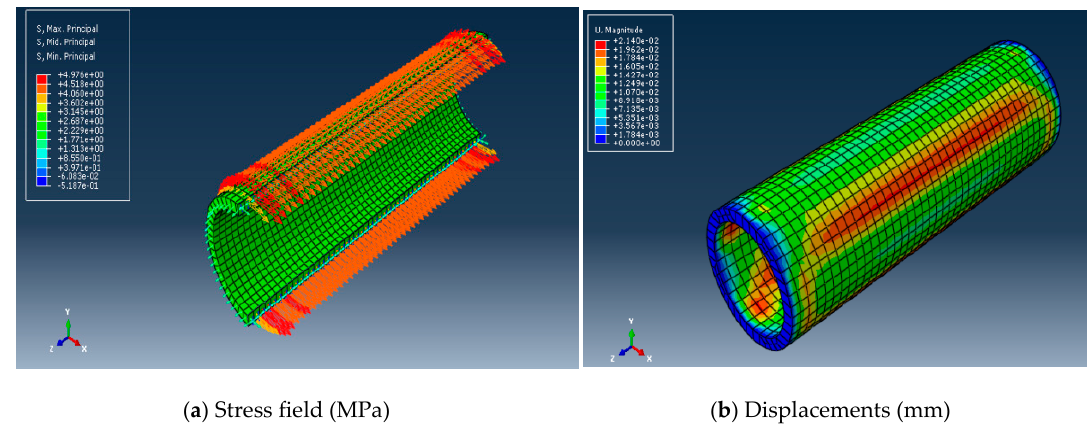
Figure 26. Results for the pipe DN 315.